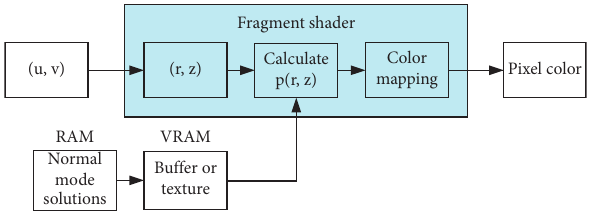
Figure 4: The flowchart of fragment shader.